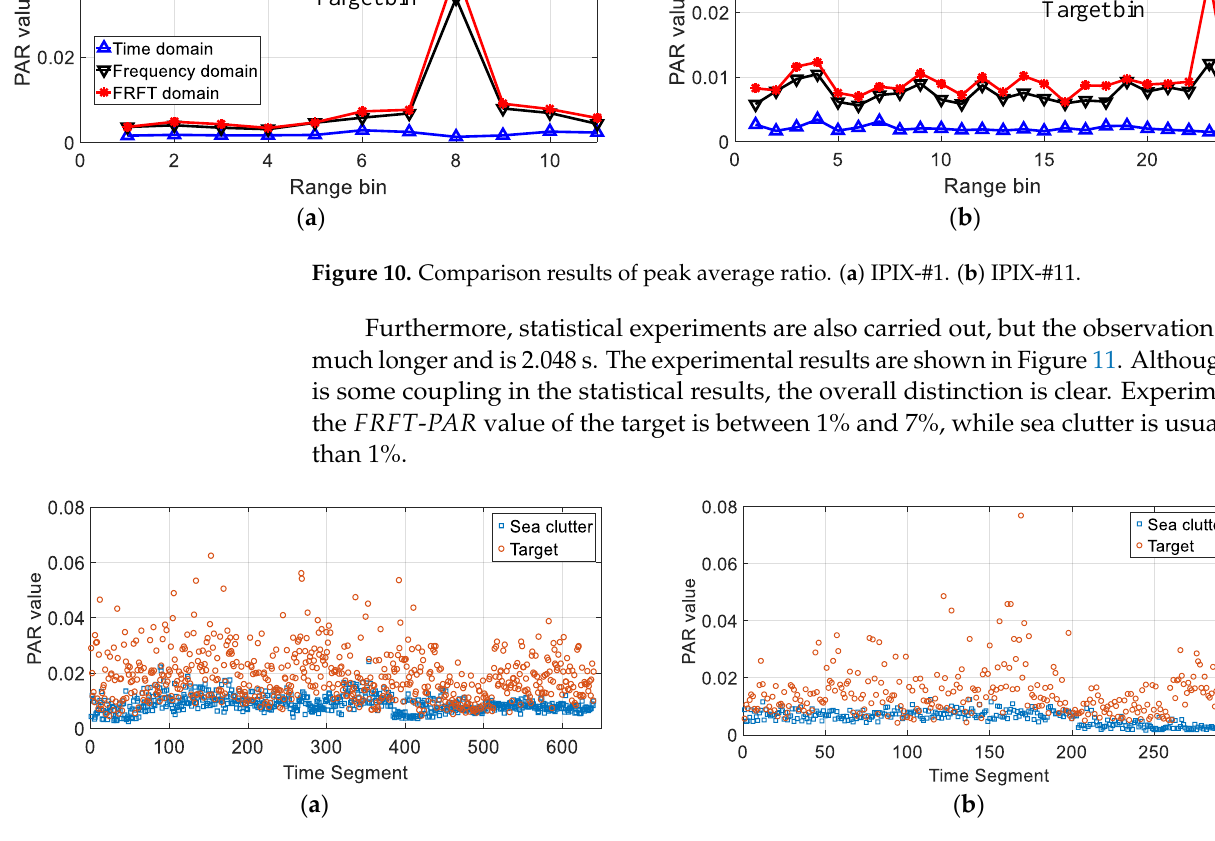
Figure 11. Statistical results of the FRFT-PAR. ( a ) FRFT-PAR of IPIX-1993. ( b ) FRFT-PAR of IPIX-1998.